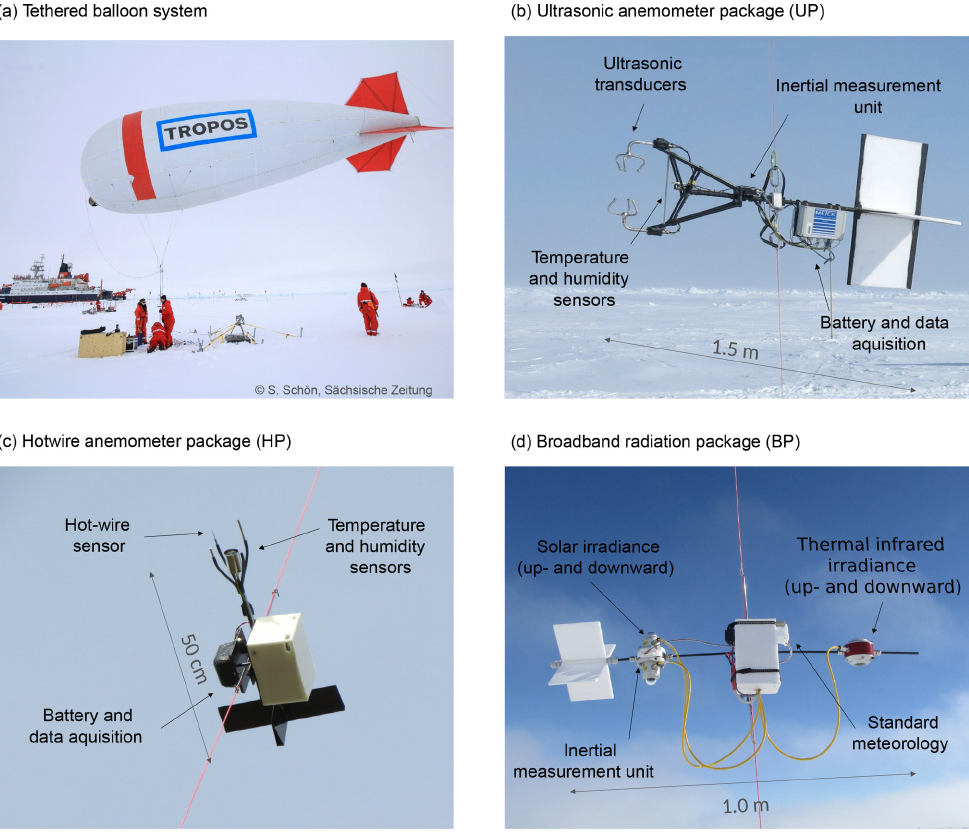
Figure 1. The tethered balloon system on the ice floe next to RV Polarstern (a) and photographs of the individual instrument packages for turbulence (b, c) and radiation (d)